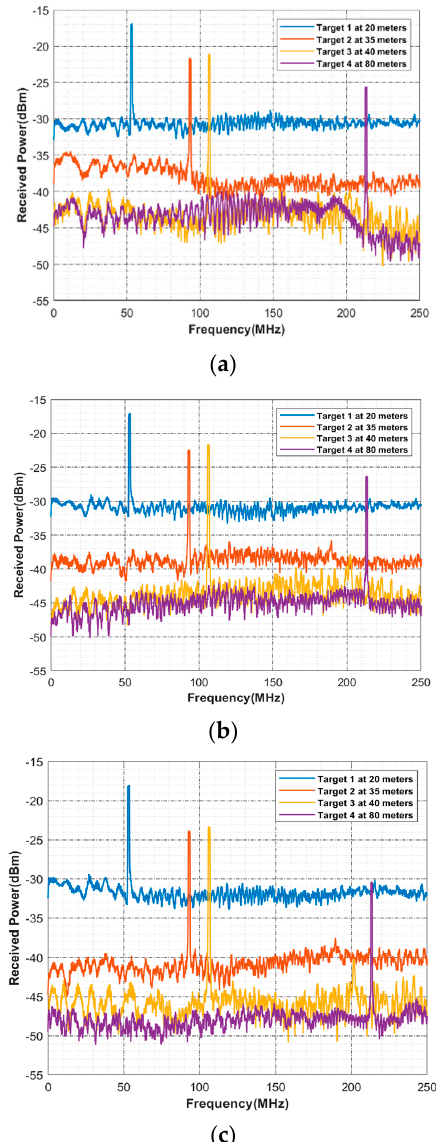
Figure 3. Detection of four targets under the atmospheric impact of ( a ) low fog ( b ) medium fog ( c ) thick fog.